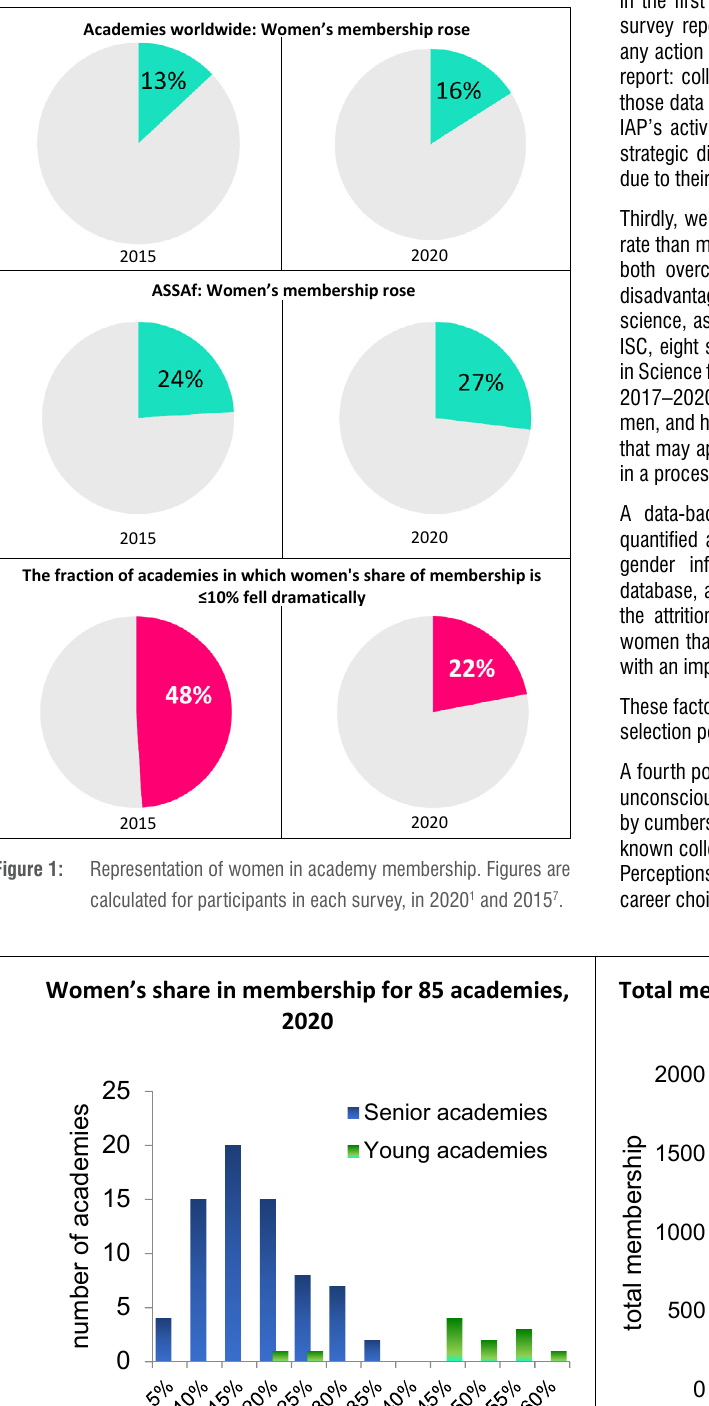
Young academies Senior academies